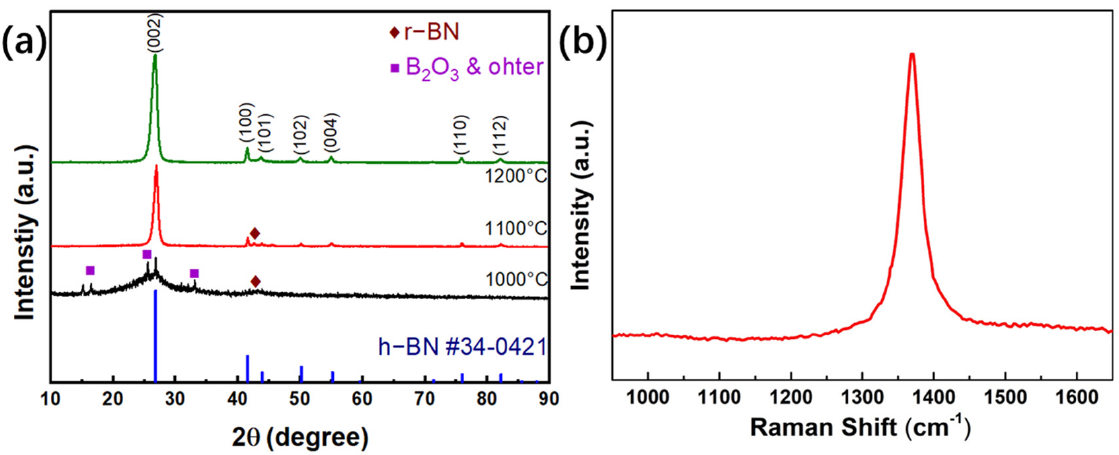
Figure 1. ( a ) XRD of the BN nanomaterial prepared at different temperature; ( b ) Raman spectrum of BN prepared at 1200 °C.